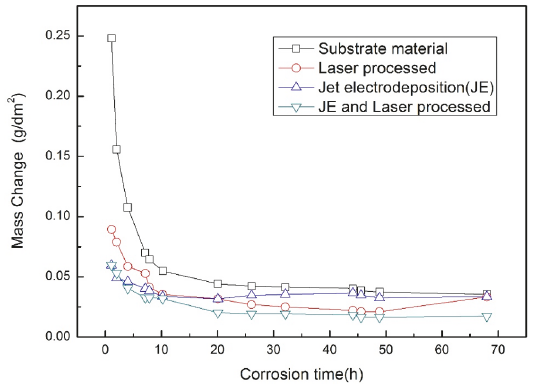
Figure 4: Corrosion rate versus time